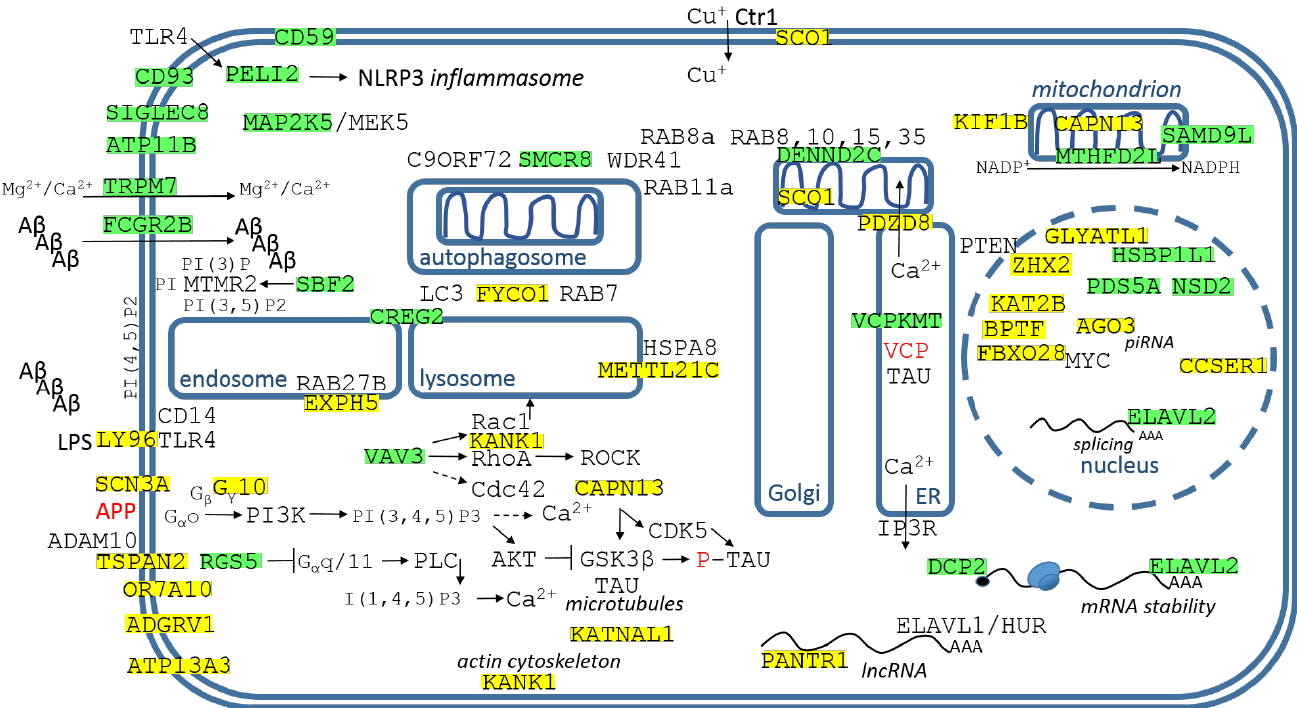
Figure 6. The situation when the prion-like oligomerization consumes the Aβ signal peptide. Green highlights show the alignments with the reverse complement sequence (post-transcriptionally not promoted), yellow highlights show the alignments with the complement sequence (post-transcriptionally not repressed).